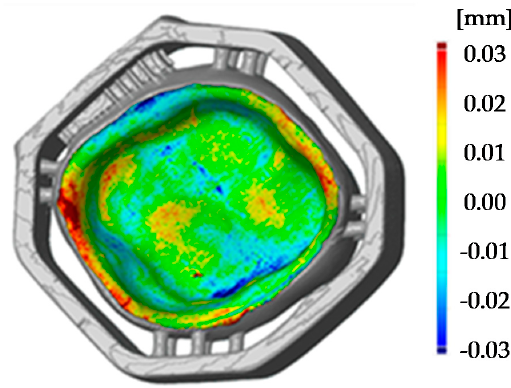
Figure 10. Comparison of two 3D surface models (sintered molar crown with ‘milling’ support, design C).